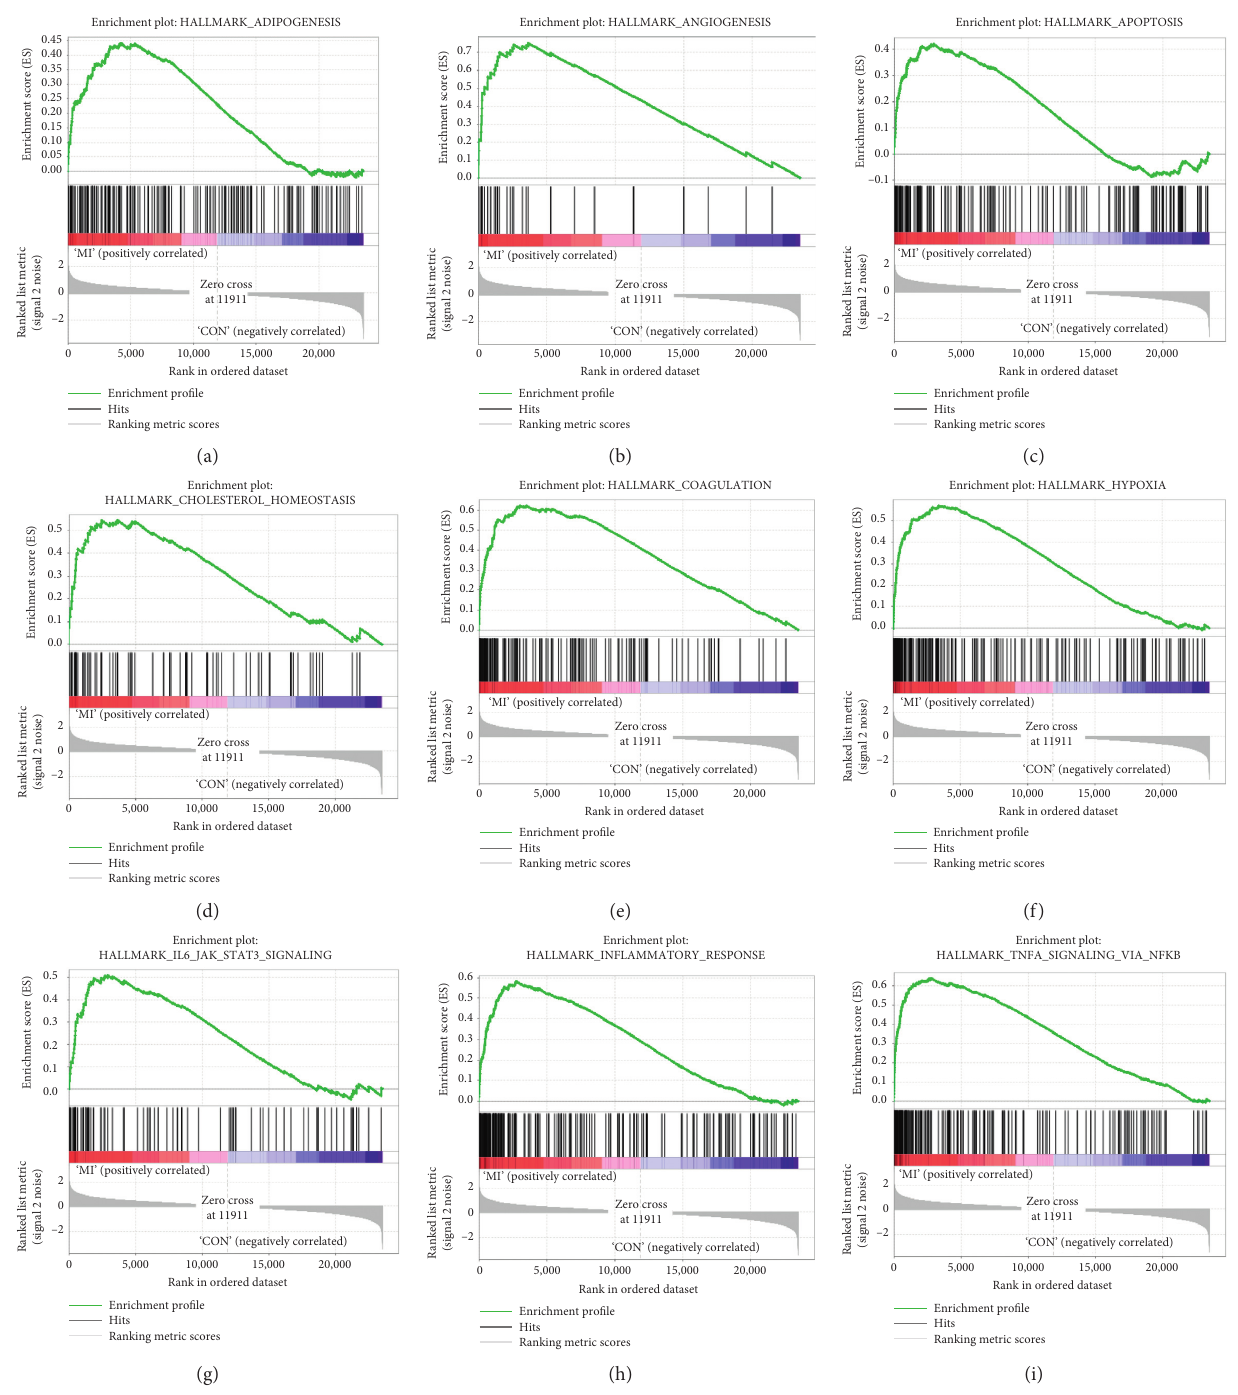
Figure 3: Gene set enrichment analysis of GSE19339. Significantly enriched gene sets were selected based on threshold values: | normalized enrichment score (NES)| > 1, nominal p value < 0 . 05, and FDR q value <